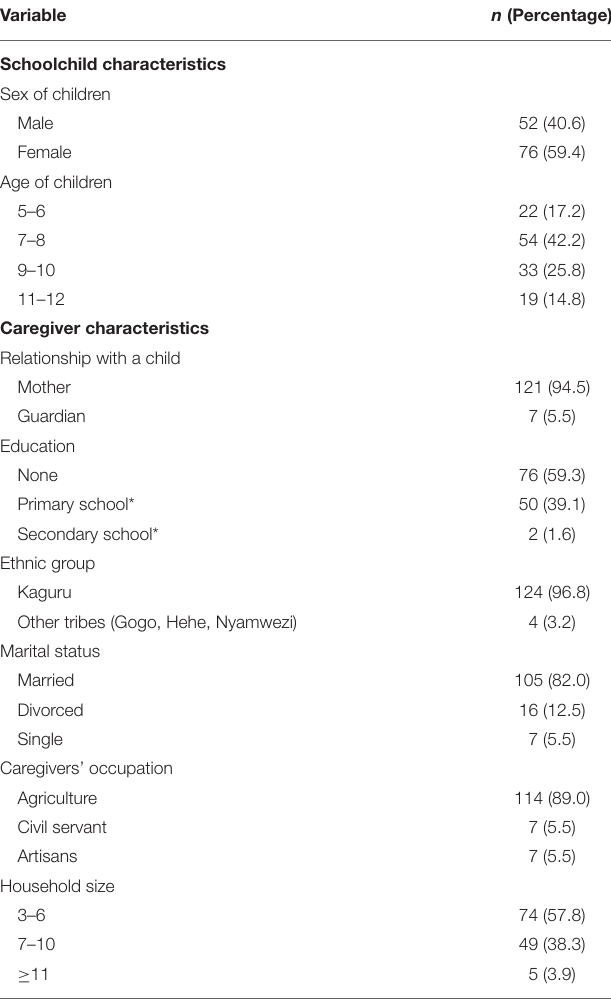
TABLE 2 | Socio-demographic characteristics of school aged children and their caregivers in Kongwa ( n = 128). Variable n (Percentage)